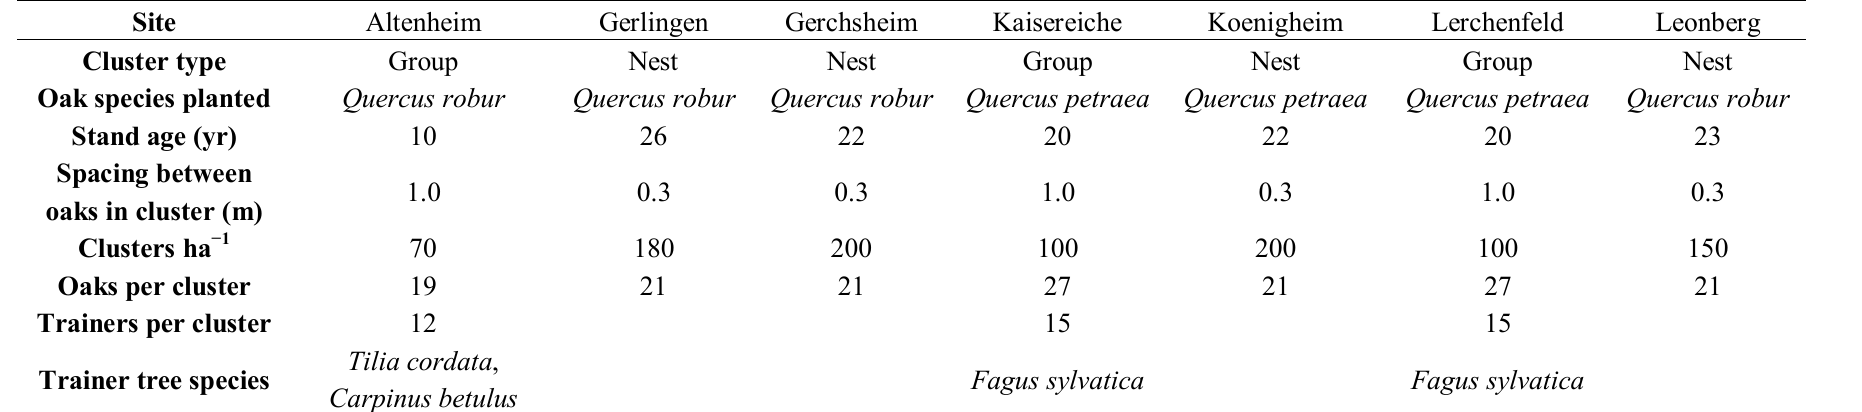
Table 2. Characteristics of studied cluster